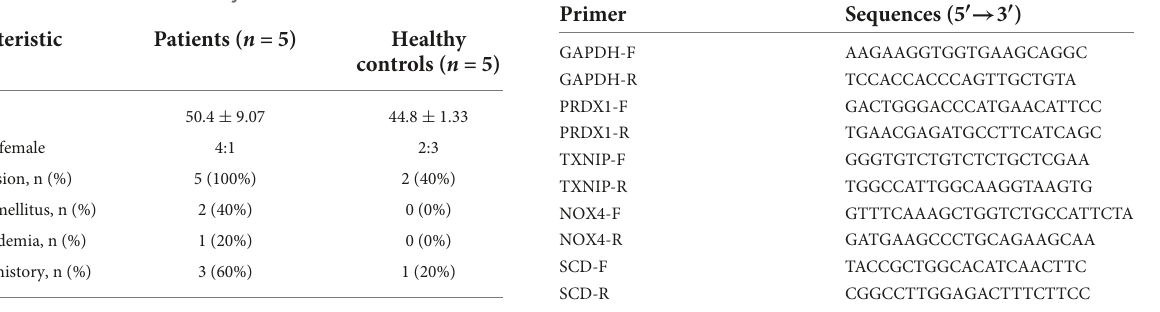
TABLE 2 Primer sequences used for qRT-PCR.